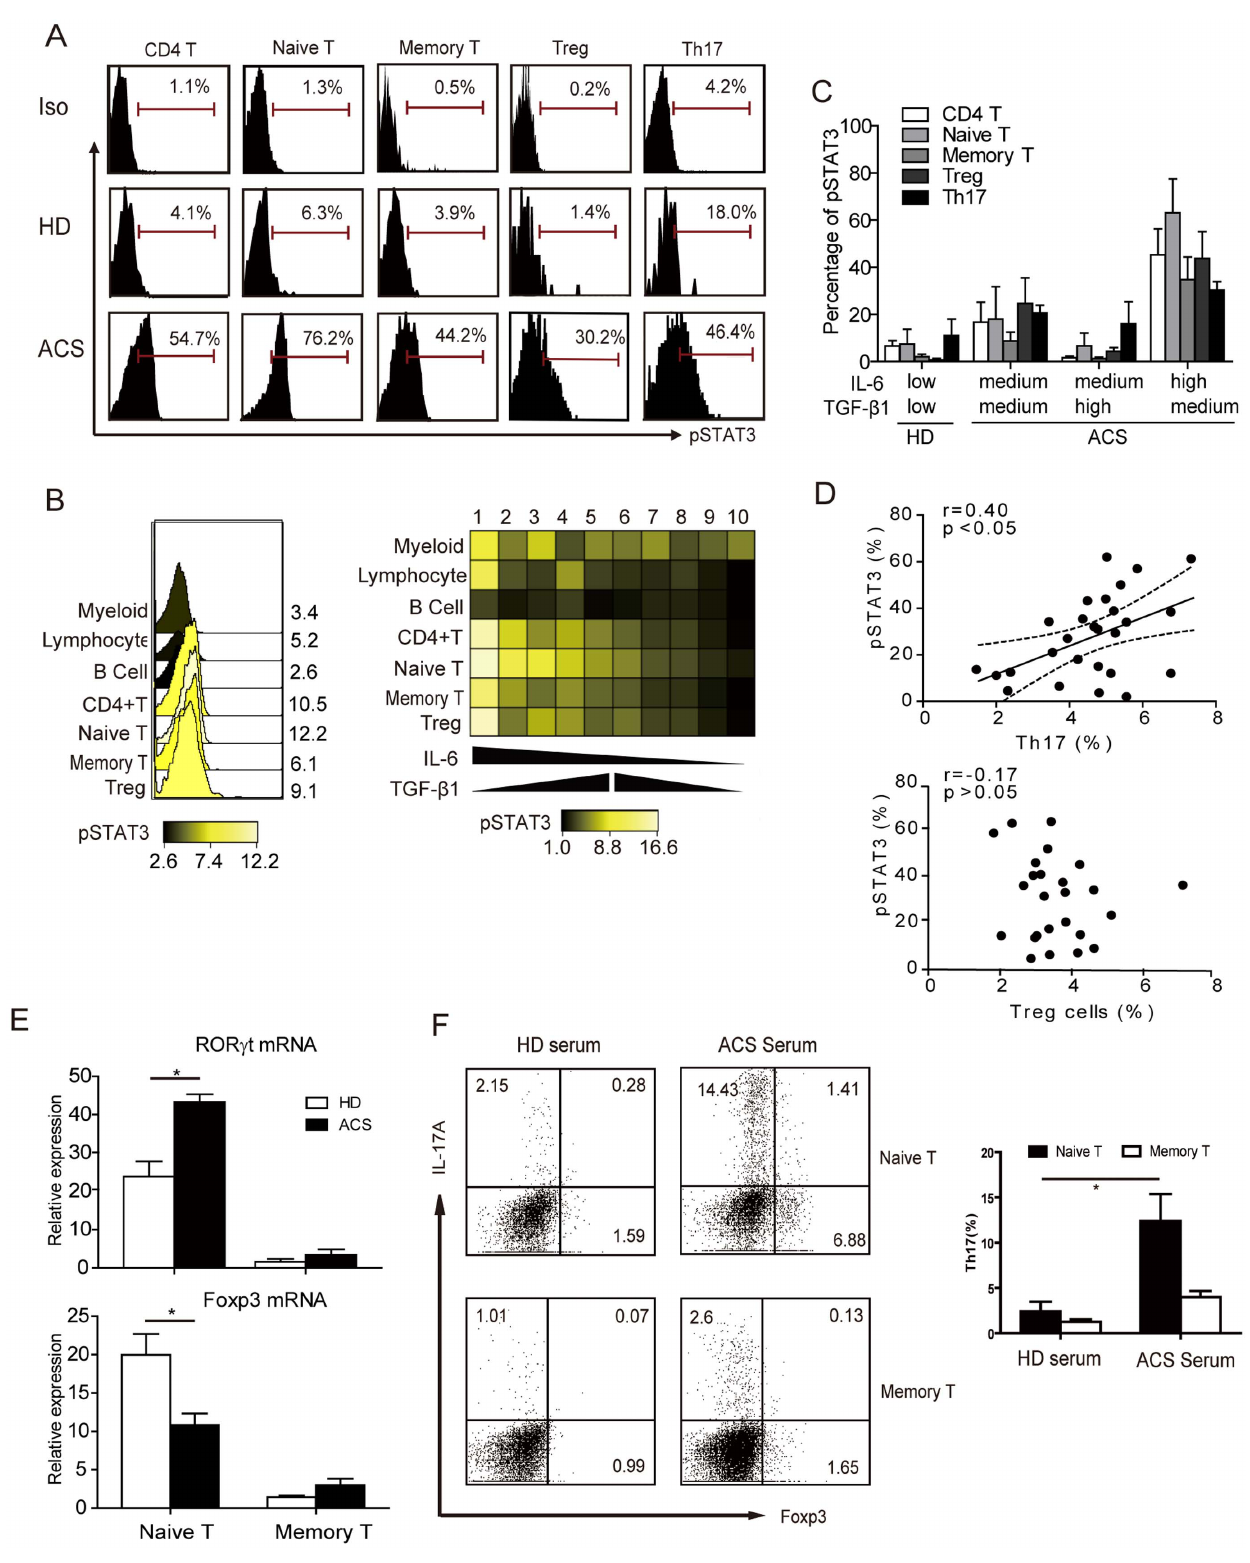
Figure 3. IL6-STAT3 signaling in patients with ACS. (A) Representative FCM histograms of pSTAT3 levels in CD4 + T cells, naı¨ve T cells, memory T cells, Treg cells and Th17 cells in HDs and ACS patients. Data are representative of 5 independent experiments. (B) Overlay and heatmap summary of STAT3 phosphorylation in immune cell subtypes from PBMCs defined as: myeloid cells, lymphocytes, B cell, CD4 + T cells, naı¨ve T cells, memory T cells and Treg cells in ACS patients (n=10) with different levels of IL-6 and TGF- b 1. The color scale indicates the difference in the log2 mean intensity of pSTAT3. (C) Statistical analysis of the expression of the pSTAT3 levels in T cell subsets from ACS patients (n=10) with different levels of IL-6 and TGF-